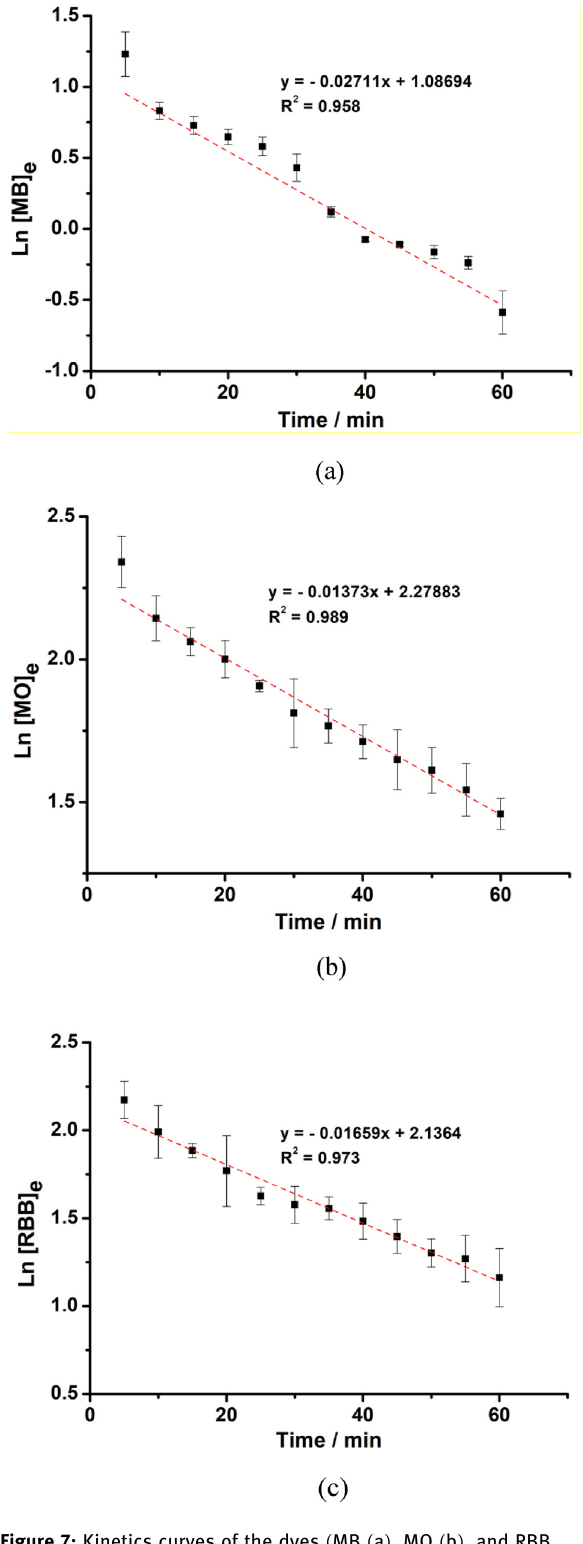
Figure 7: Kinetics curves of the dyes ( MB ( a ) , MO ( b ) , and RBB ( c )) destruction by